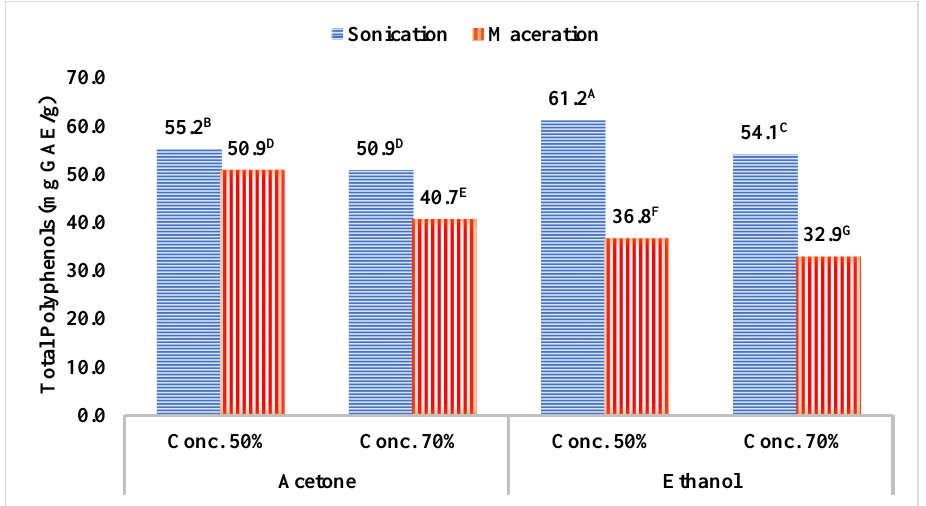
Figure 2. Total phenolic content (mg GAE/g of Extract) of lemongrass leaves extracts by sonication and maceration technique. A–H means that the yields of different letters are significantly different.